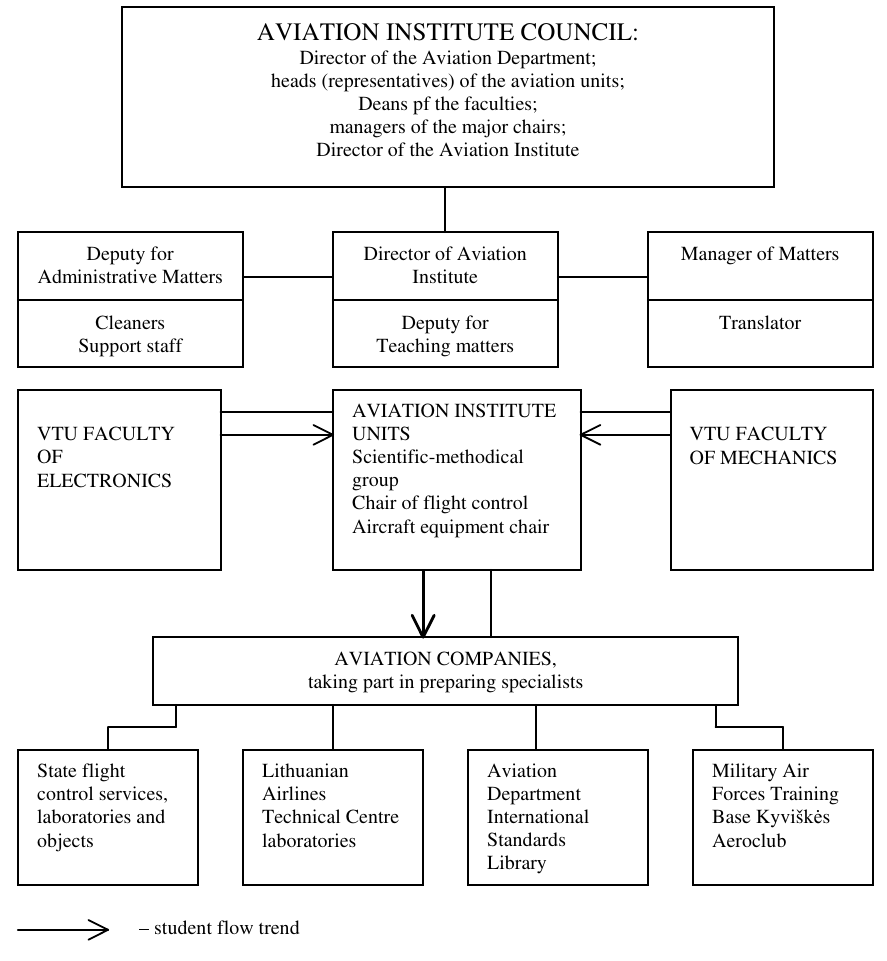
Fig 1. The Aviation Institute structural project